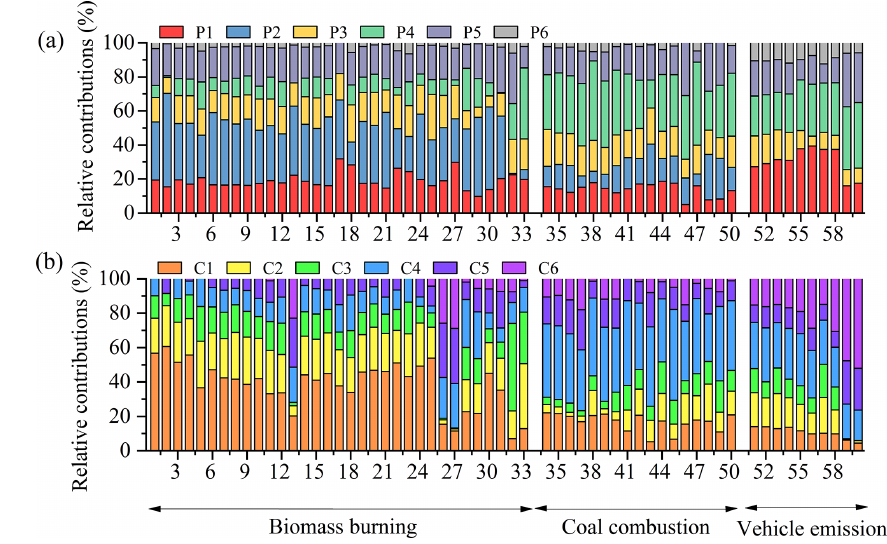
Figure 3. The relative contributions of each PARAFAC component of WSOC (a) and MSOC (b) from the three sources.